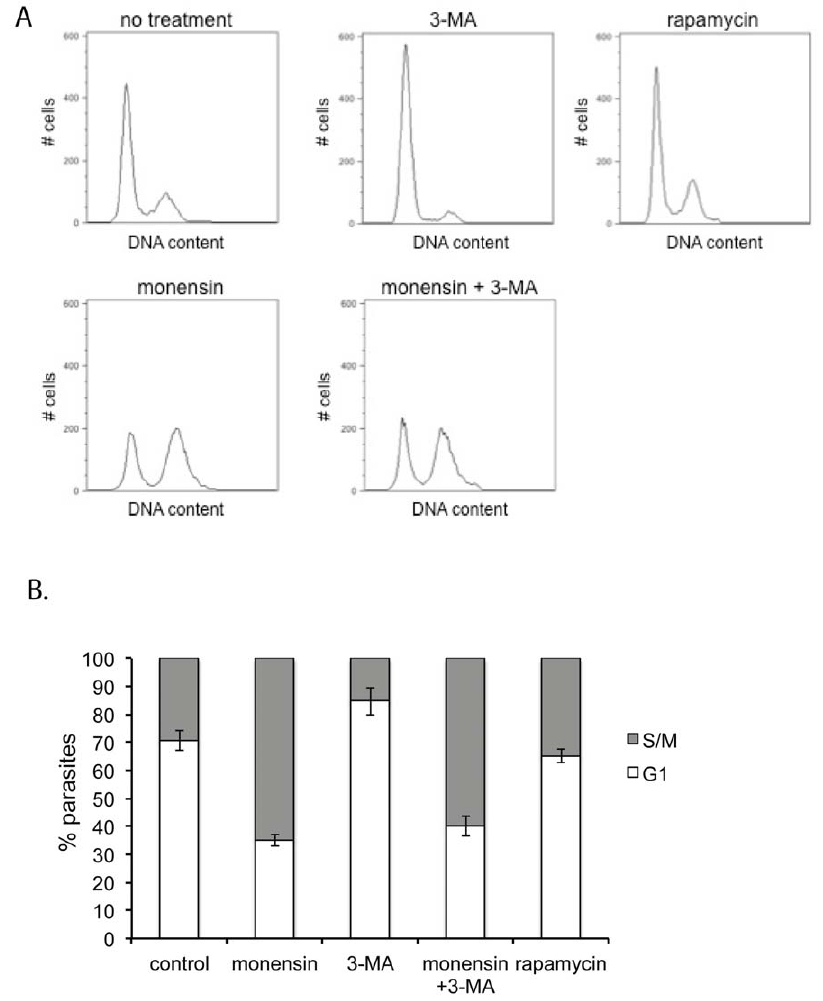
Figure 7. Rapamycin alone does not induce cell cycle arrest, nor does 3-MA rescue monensin-induced cell cycle arrest. Flow cytometry analysis of T. gondii cell cycle in response to rapamycin, monensin and 3-MA. Intracellular parasites were exposed to either normal culture medium or normal culture medium plus 0.75 ng/ml monensin, normal culture medium plus 10 mM 3-MA, normal culture medium plus 0.75 ng/ml monensin and 10 mM 3-MA, or normal culture medium plus 5 m M rapamycin. After 24 hours exposure, DNA content was measured by Sytox green staining. (A) Representative histograms are shown. Each histogram represents 10,000 total events. (B) Percentage 6 standard deviation of parasites in G 1 or S/M phases determined by gating for three separate experiments is indicated in the bar graphs.